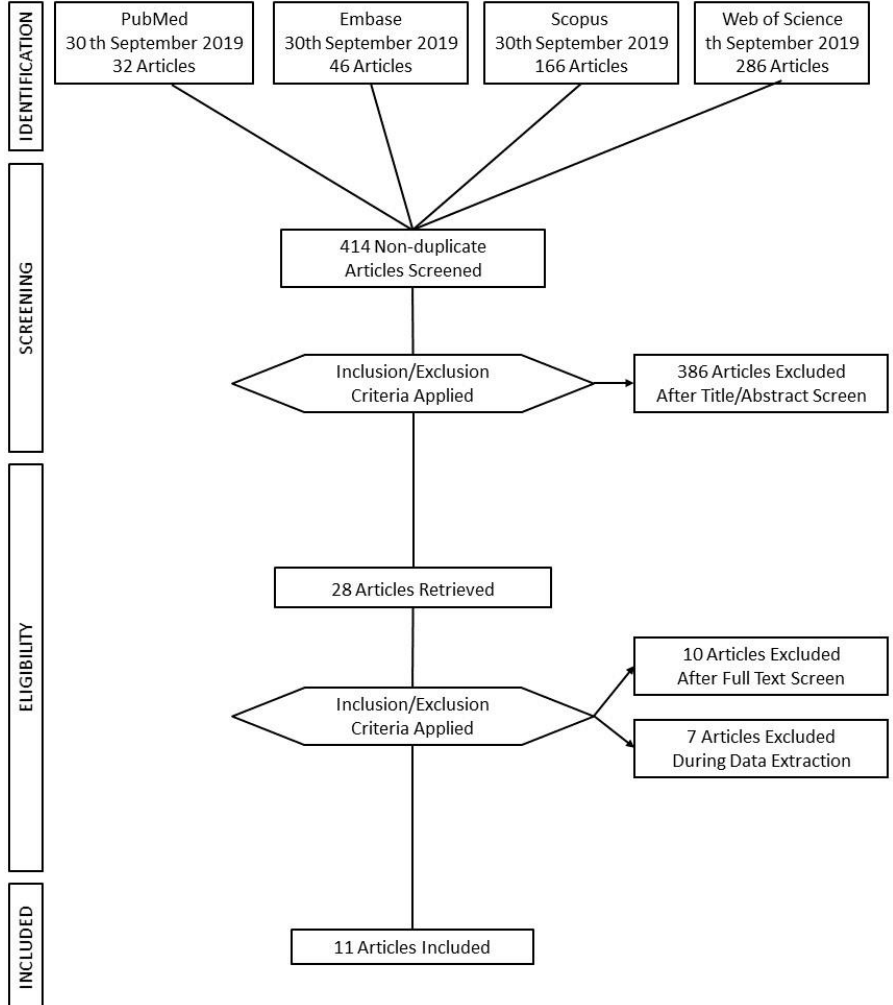
Figure 1. Flow Chart.